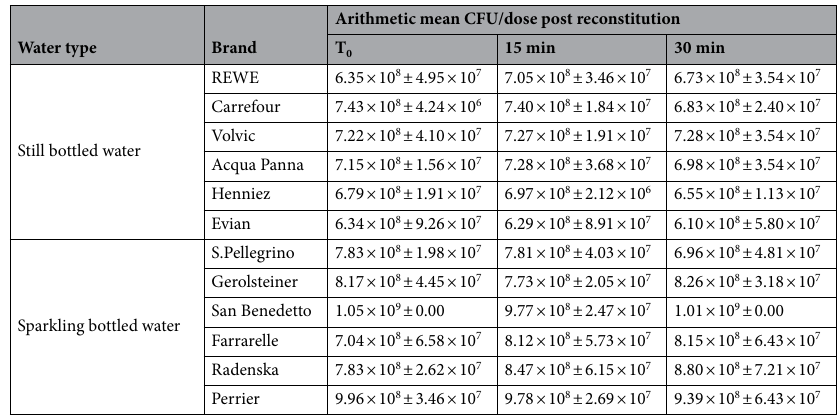
Table 6. PXVX0200 viability when reconstituted in European still and sparkling natural spring waters (2020).